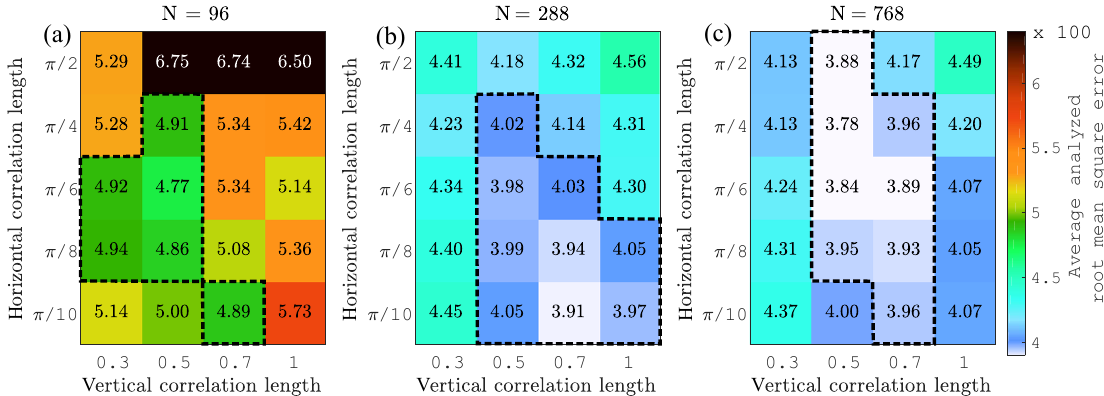
Figure 8. Values of the average analyzed error for assimilations performed using the dataset generated by evolution A of Fig. 3, with different sizes of the ensemble, and vertical and horizontal correlation lengths. (a) For 96 ensemble members, (b) for 288 ensemble members and (c) for 768 ensemble members. The dashed lines delimit the zones for which errors are less than (cid:15) a